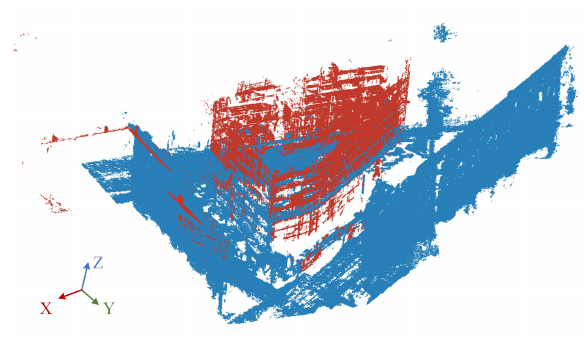
Figure 4. Registration results of two scans of the construction